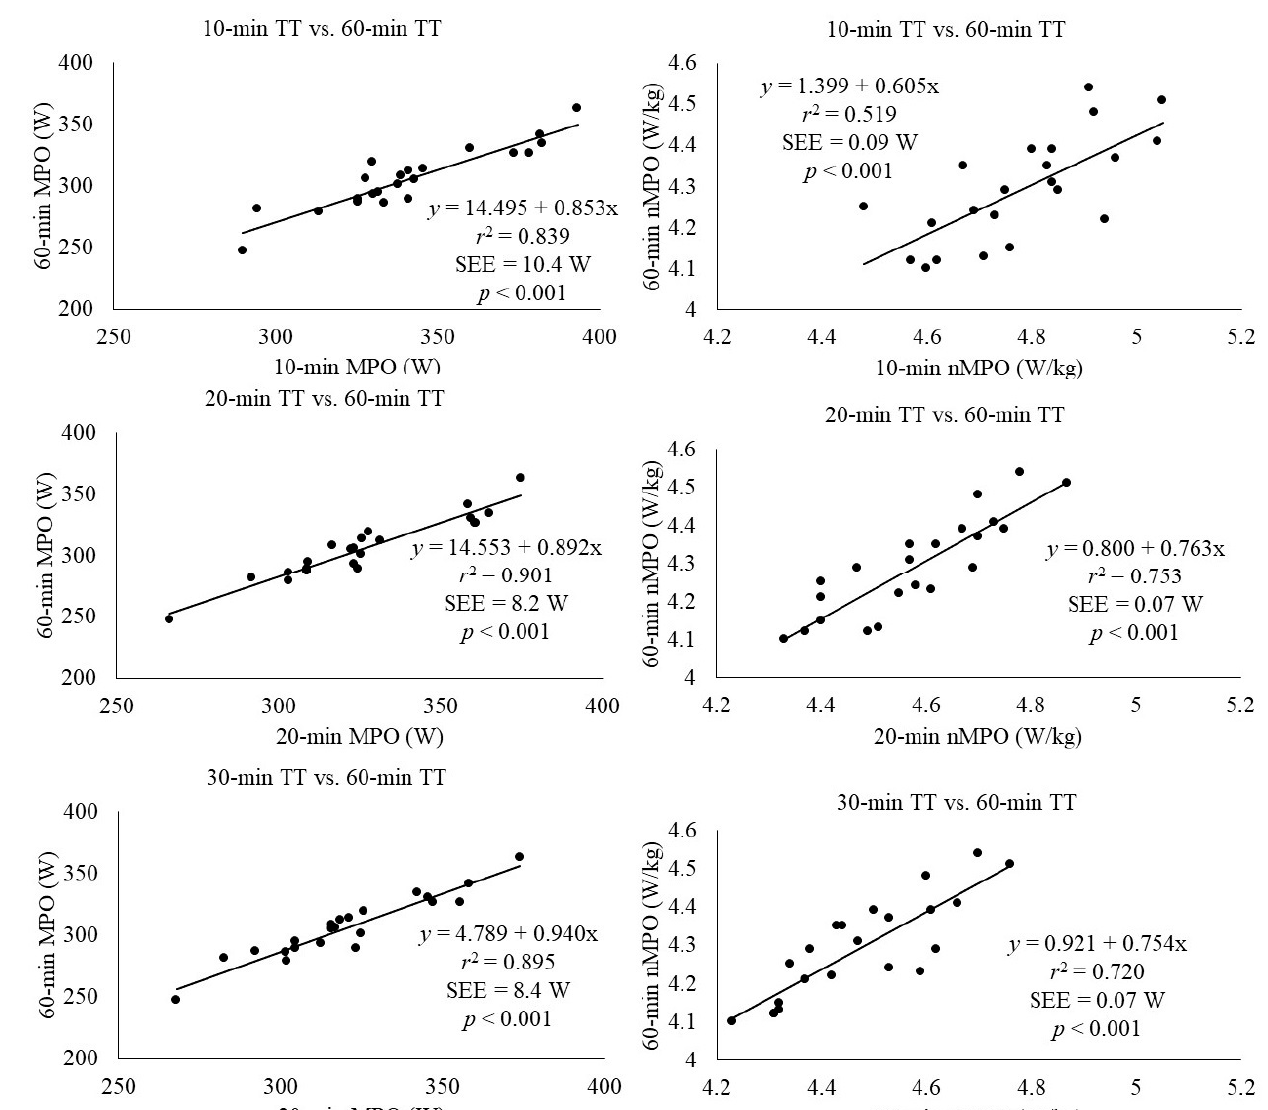
Figure 3. Association between the mean power output achieved during a 60-min time trial (TT) and the MPO achieved during 10-min, 20-min and 30-min TTs in trained endurance runners. (Absolute values in left column and relative values in right column). The average value of each runner was used for each TT. Circles indicate individual data. The solid lines represent the predictive linear regression model between 60-min TT and the shorter TTs. SEE: standard error of estimate; MPO: mean power output; nMPO: normalized mean power output. Table 3. Level of agreement between power output obtained during different running based-time trials regarding the reference duration (60-min time trial).